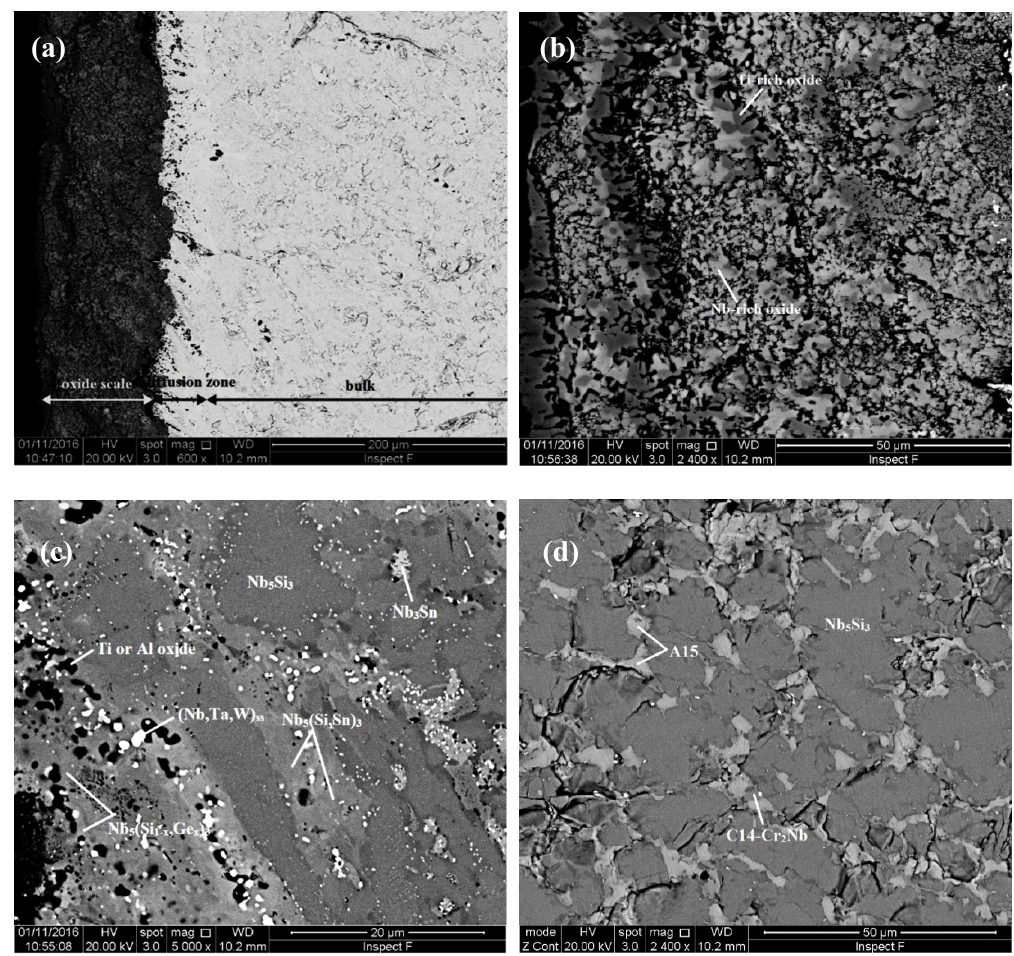
Figure 10. BSE images of the microstructure of a cross section of the oxidized alloy JZ3 at 1200 °C, ( a ) and ( b ) show the microstructure of the oxide scale, ( c ) diffusion zone and bulk, ( d ) micro-structure of the diffusion zone, ( e ) microstructure of the bulk and ( f ) white-line feature in the Nb 5 Si 3 (see text).